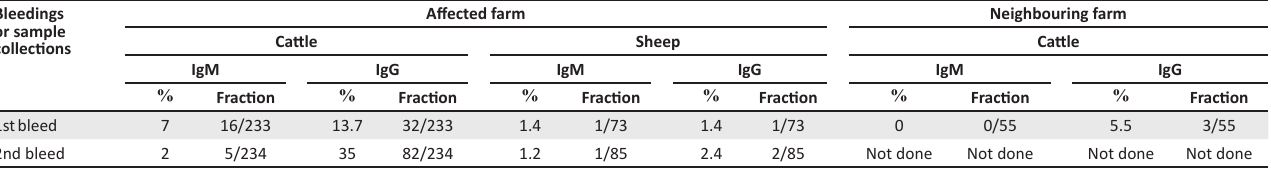
TABLE 1: Enzyme-linked immunosorbent assay results obtained from cattle and sheep serum samples collected after 2 collections of blood on 2 neighbouring farms in the Bela-Bela district, Limpopo Province. Bleedings or sample collections